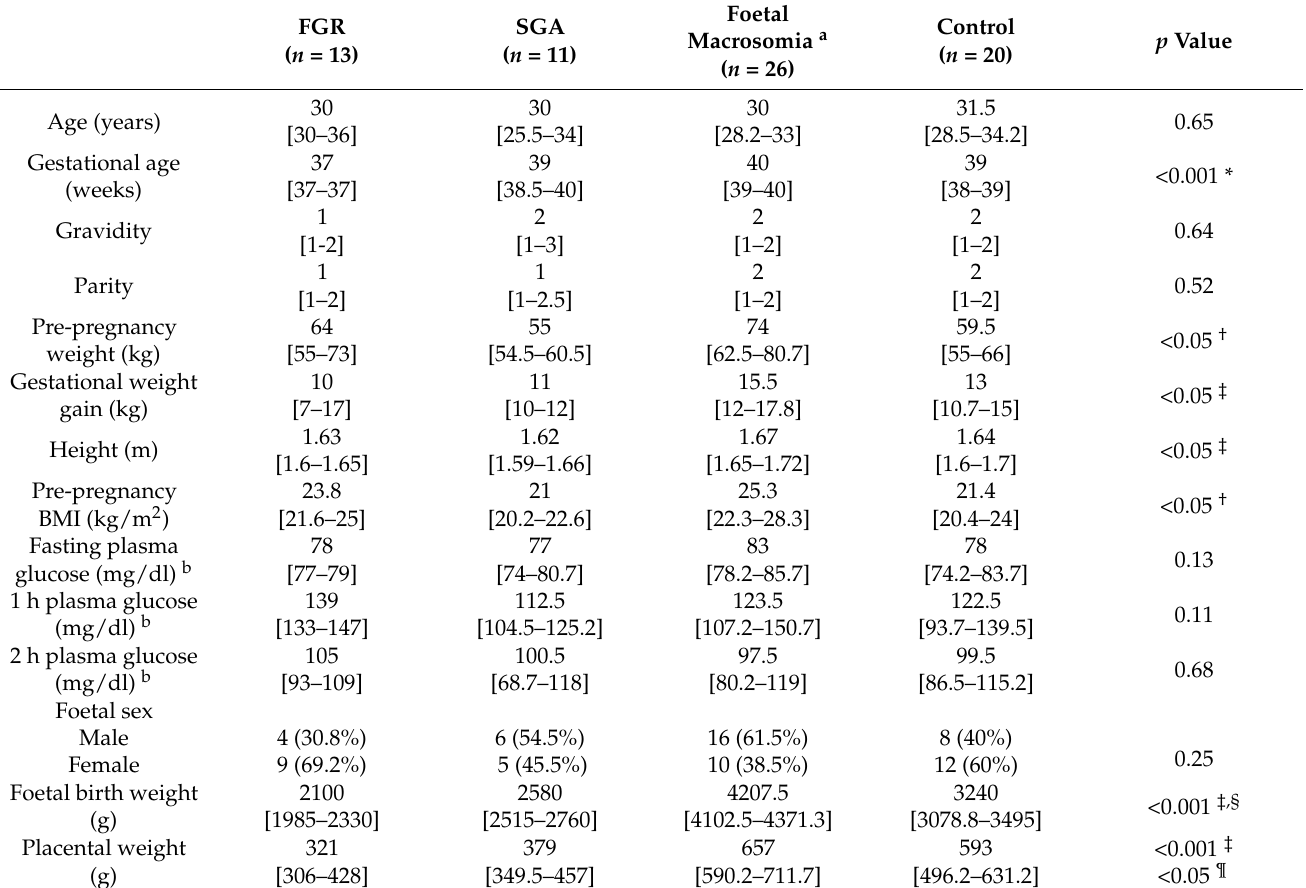
Table 3. Clinical characteristics of study